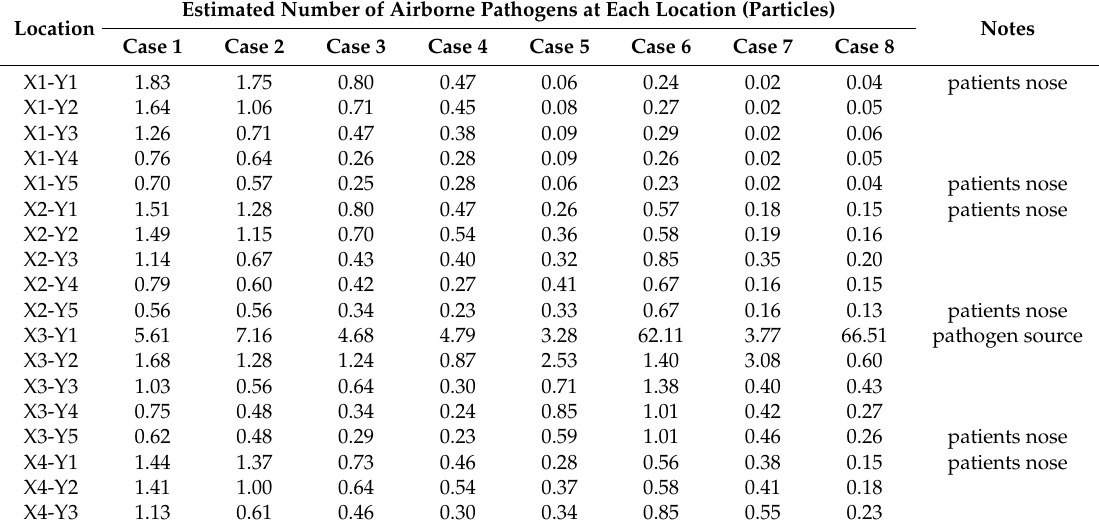
Table A1. Estimated number of airborne